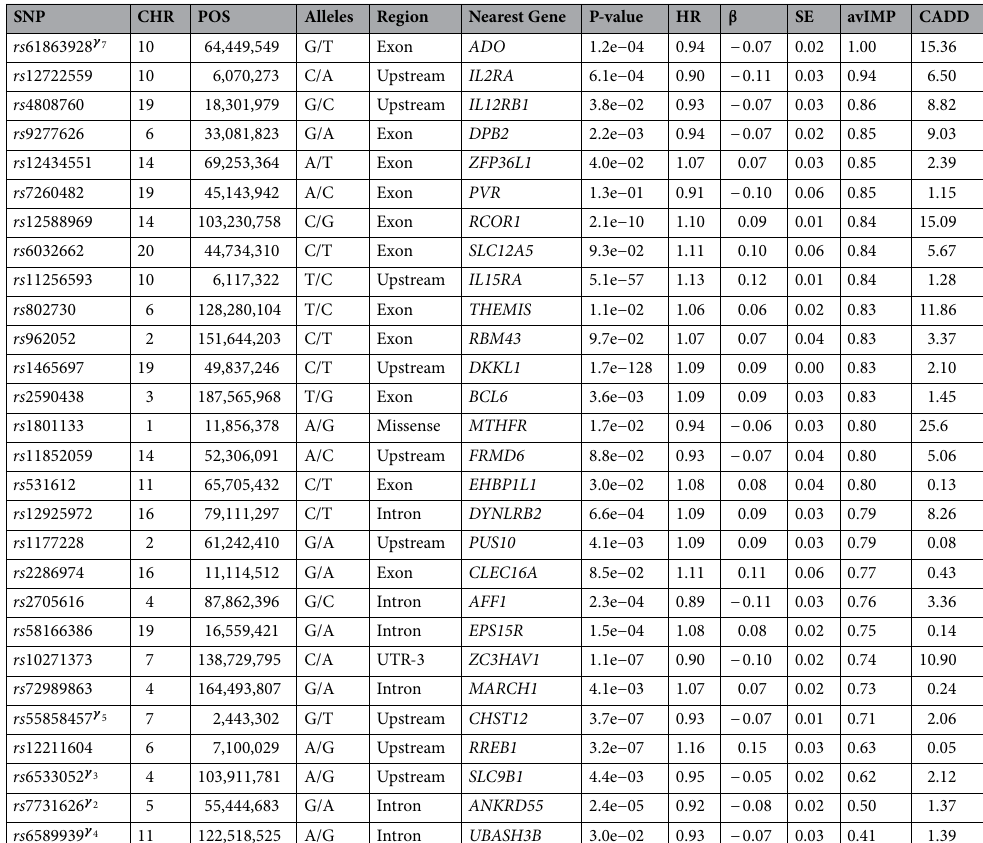
Table 2. A genetic ensemble model for predicting disability progression in multiple sclerosis. Transition- specific SNPs have superscripts γ ( . ) indicating their interaction with previous EDSS levels (EDSSPREV). The disability states based on previous EDSS levels are define by the parameters: γ 1 : state = 1; γ 2 : state = 2; γ 3 : state = 3, γ 4 : state = 4, γ 5 : stage = 5, γ 6 : state = 6, γ 7 : state = 7, γ 8 : state =